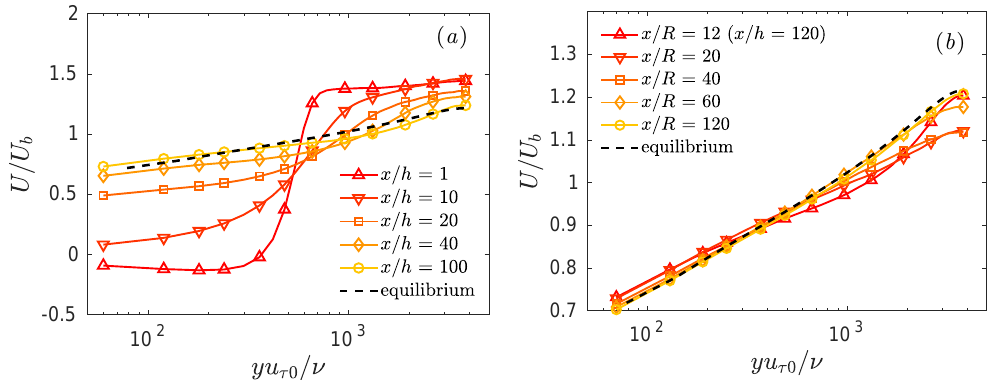
Figure 6. Distribution of U at various locations downstream of a square bar roughness element for h / R = 0.1. ( a ) Near field. ( b ) Far field.